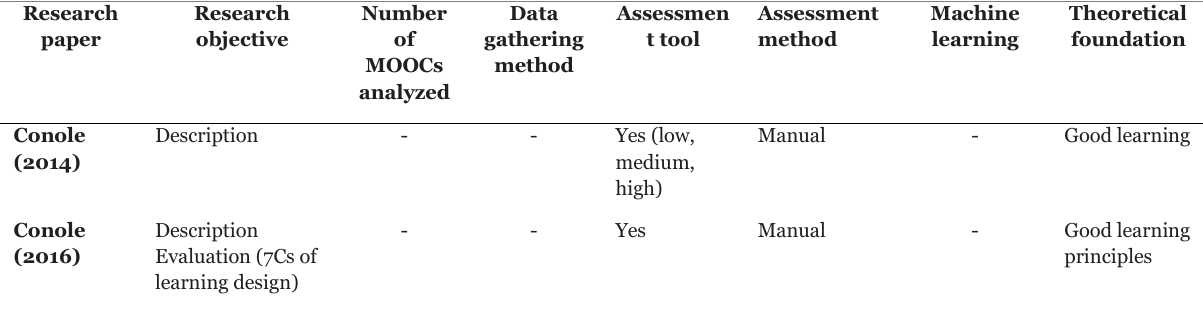
Comparing Studies That Classify